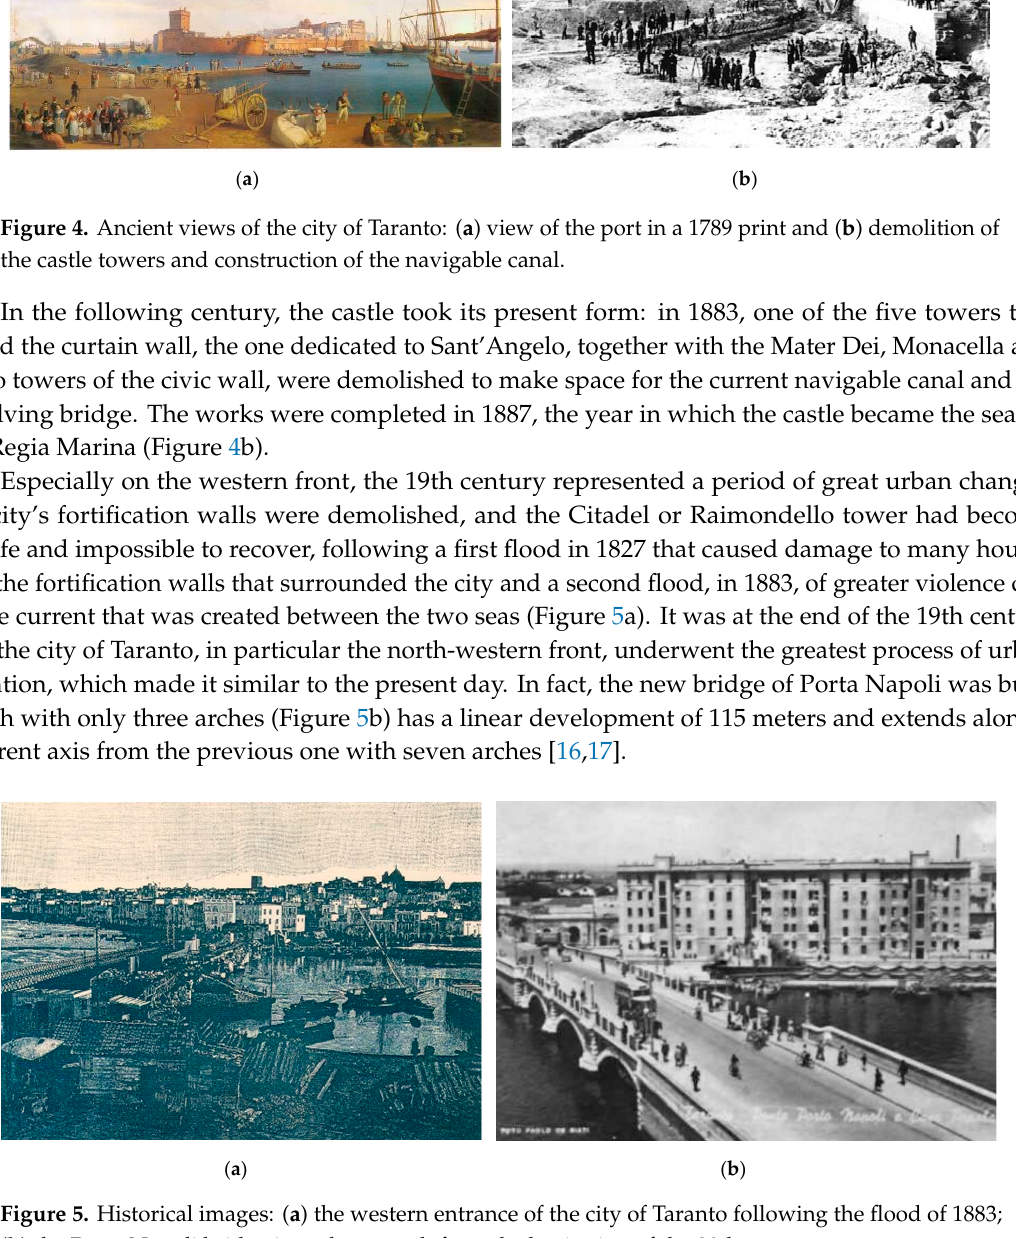
Figure 5. Historical images: ( a ) the western entrance of the city of Taranto following the flood of 1883; ( b ) the Porta Napoli bridge in a photograph from the beginning of the 20th century.